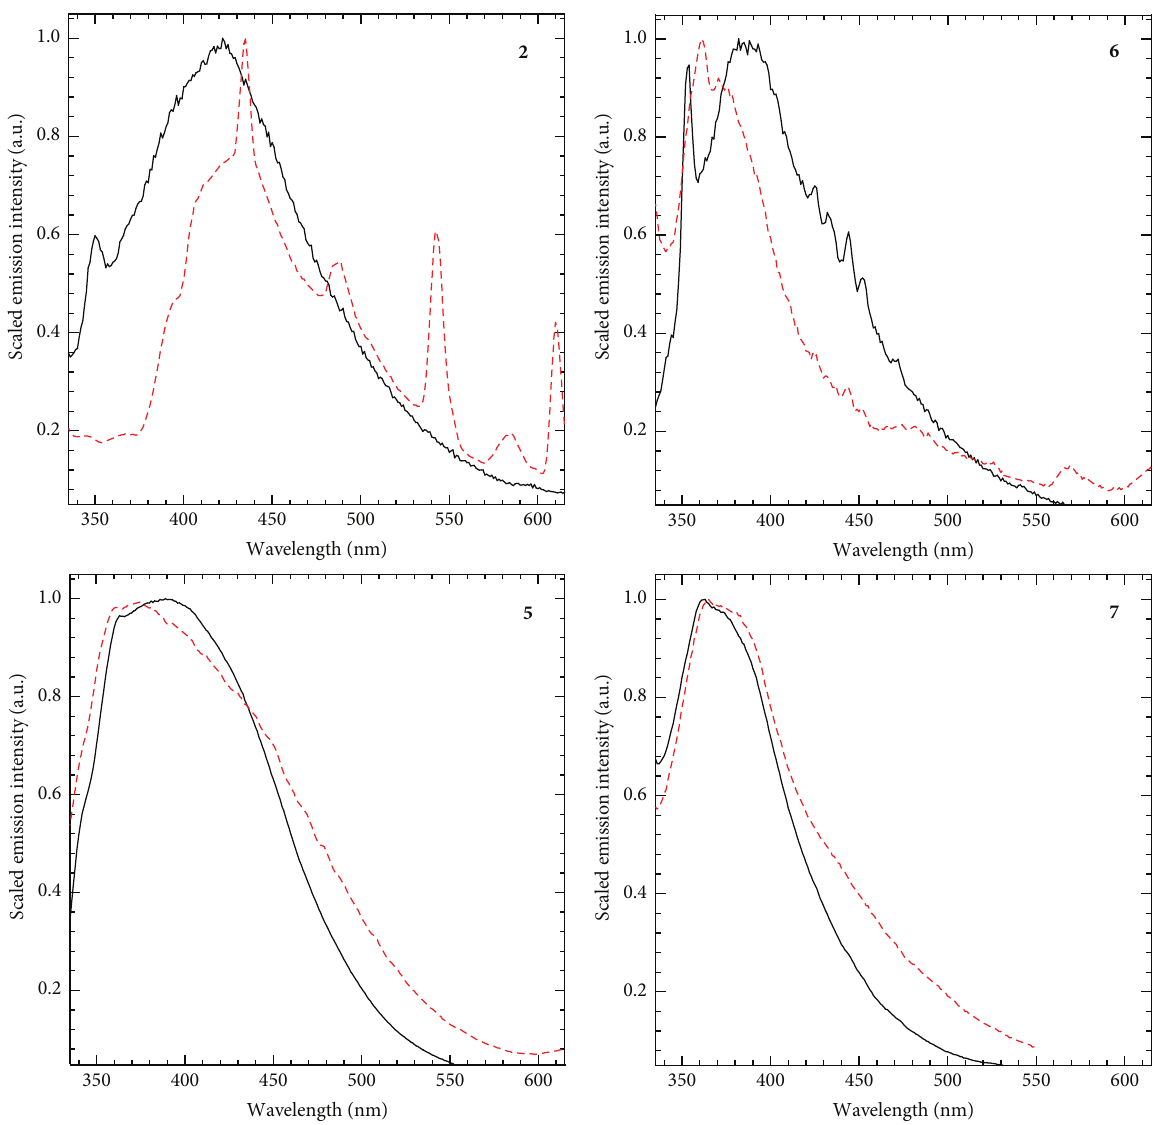
Figure 2: Normalized emission spectra recorded on degassed 2-MTHF solutions at 298 K (solid) and 80 K (dashed), excitation wavelength 320 nm. Emission intensity decreases (except 2 ) with reduced